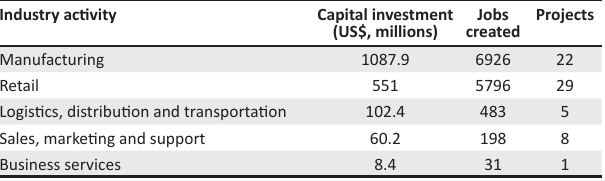
TABLE 5: Agricultural foreign direct investment outflows to South Africa by industry activity, 2003–2014. Industry